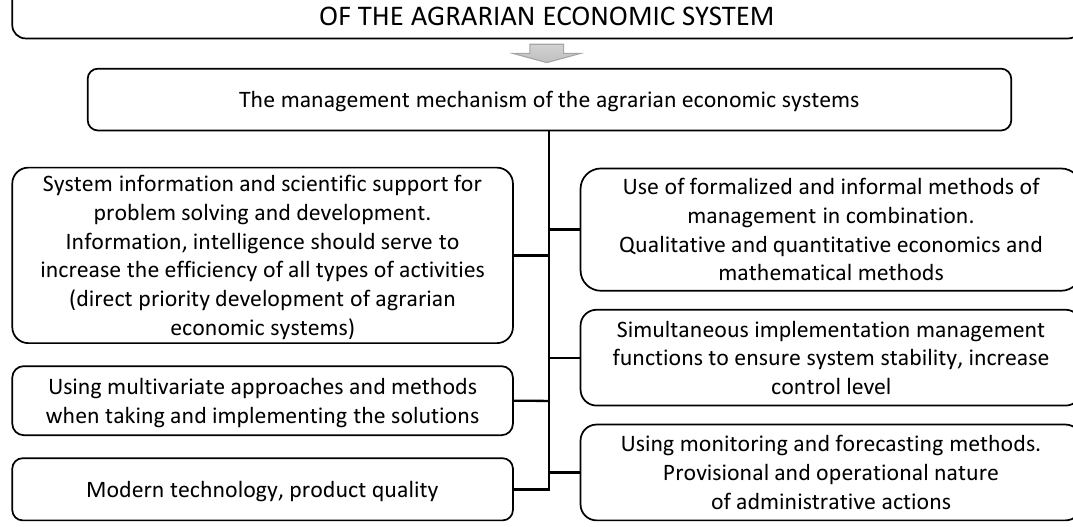
Using monitoring and forecasting methods.